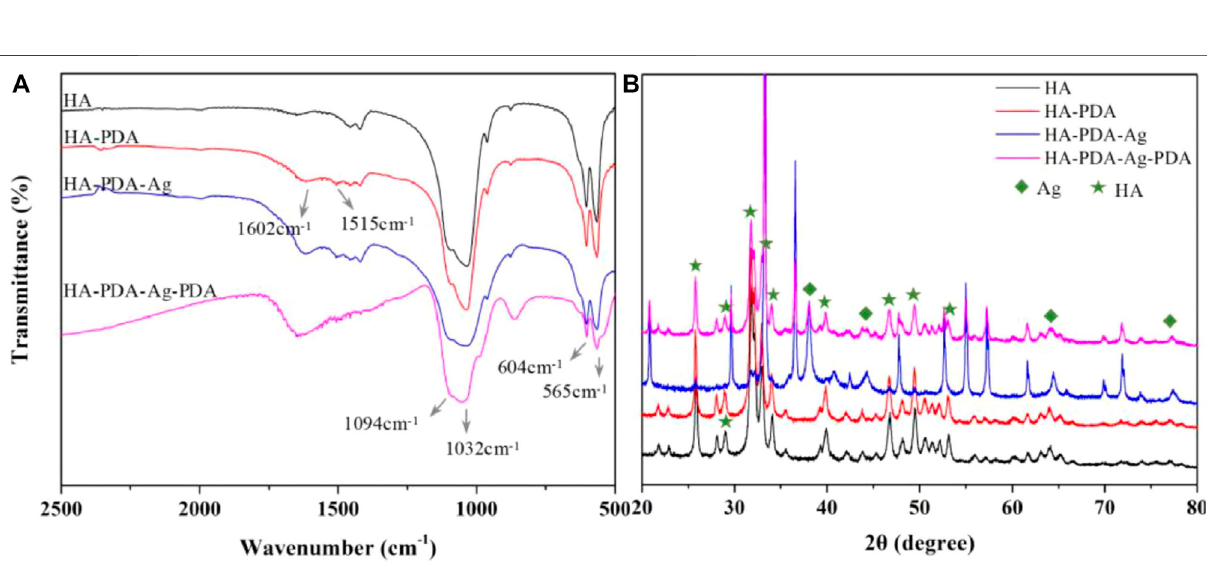
Frontiers in Bioengineering and Biotechnology |